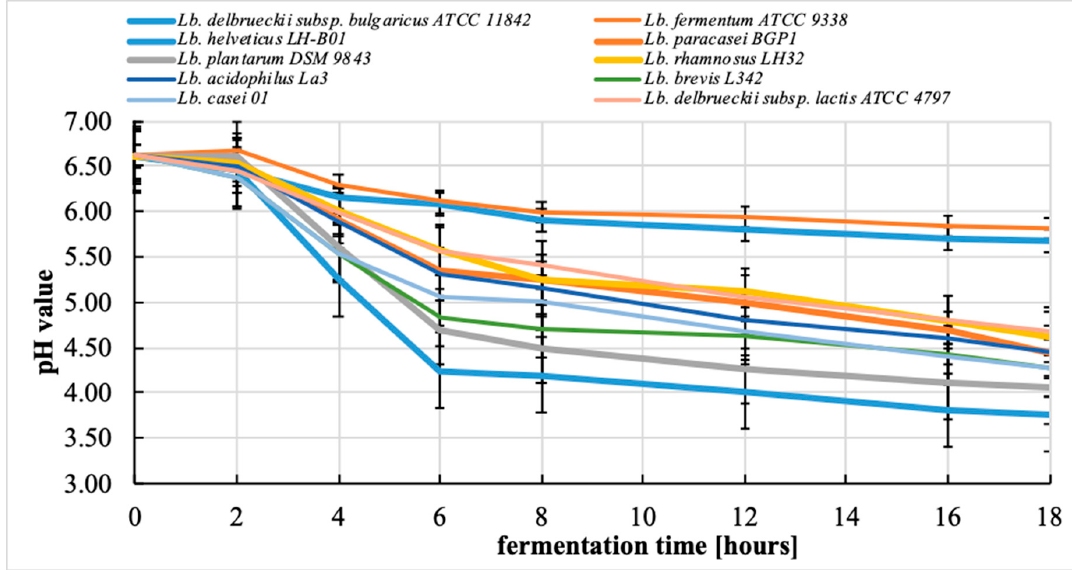
Figure 1. The pH value of bean–based beverages (means ± standard deviations, n = 4).